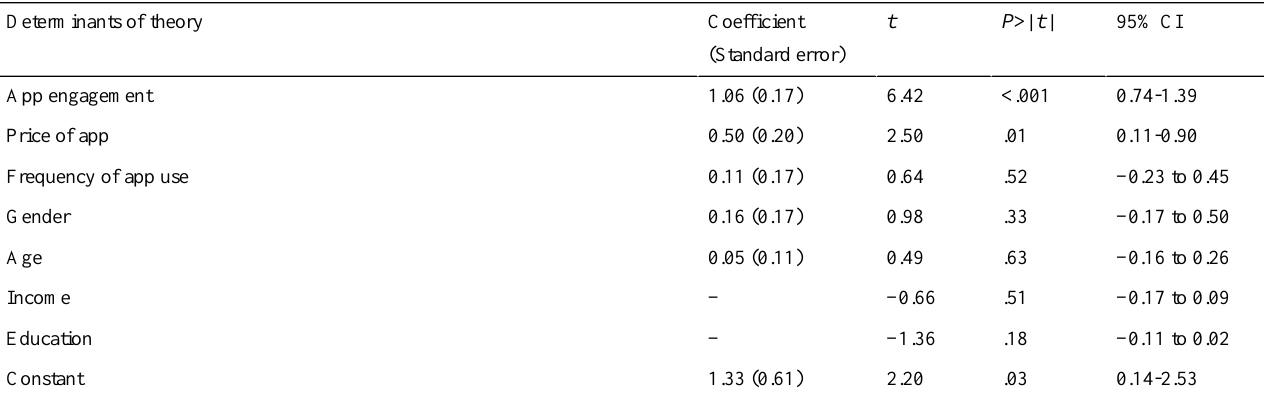
Table 5. Ordinary least squares regression results for determinants of